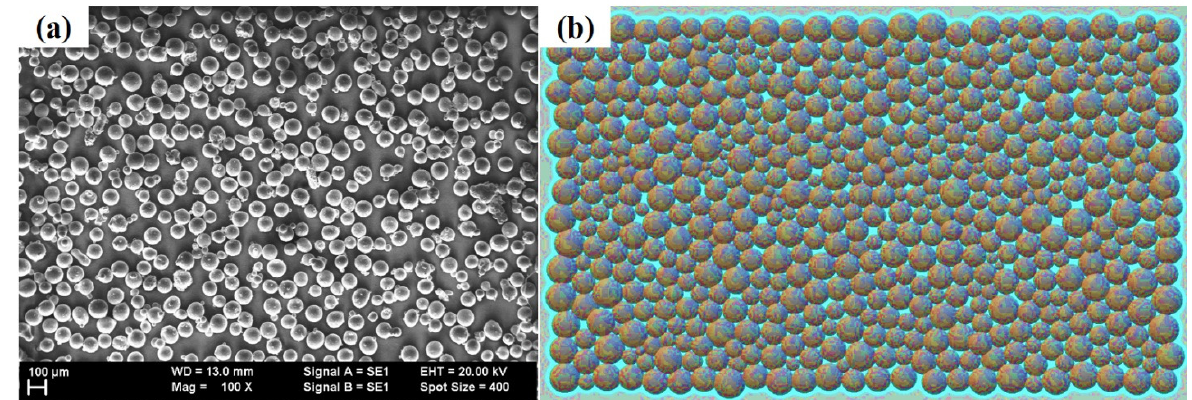
Figure 1. Ti6Al4V particulates with 50–130 µm particle size distribution ( a ) SEM and ( b ) computational results.